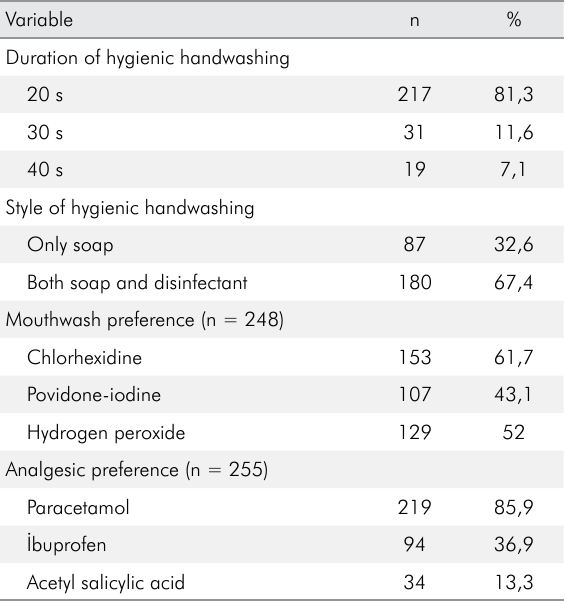
Table 4. Dentists’ preferences regarding the duration and style of hygienic handwashing, type of mouthwash, and